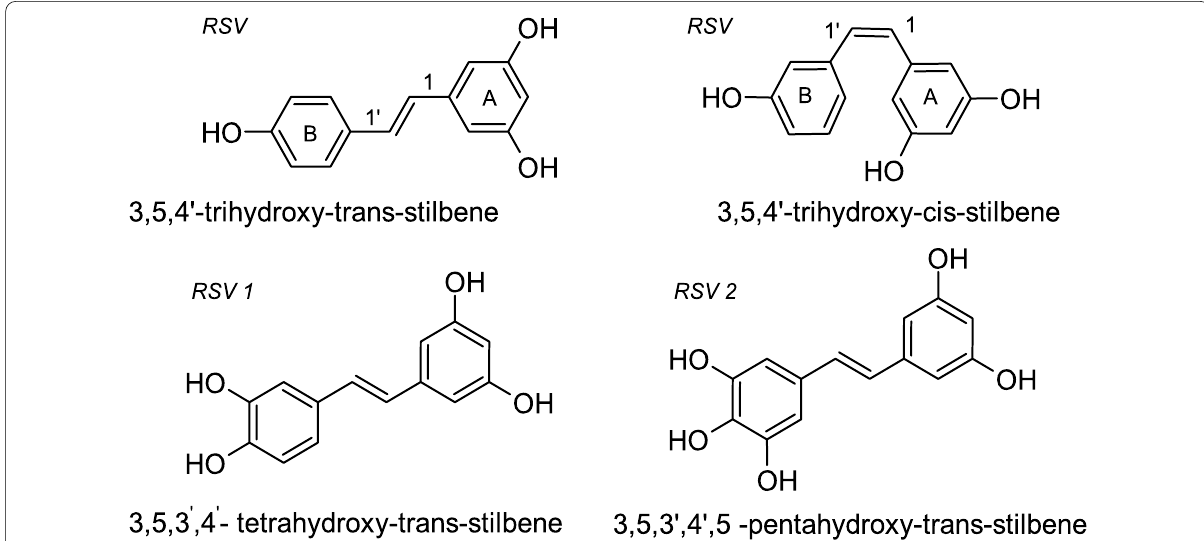
Fig. 1 Chemical structure of